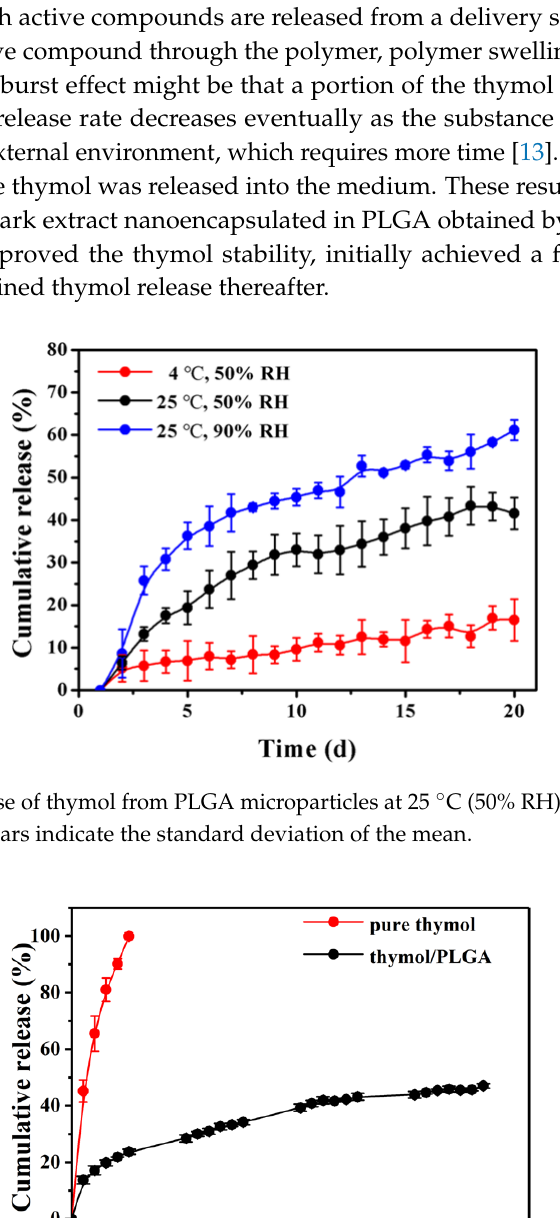
Figure 6. In vitro release of free thymol and thymol-loaded PLGA microparticles in phosphate buffer solution at 25 °C. Error bars indicate the standard deviation of the mean.